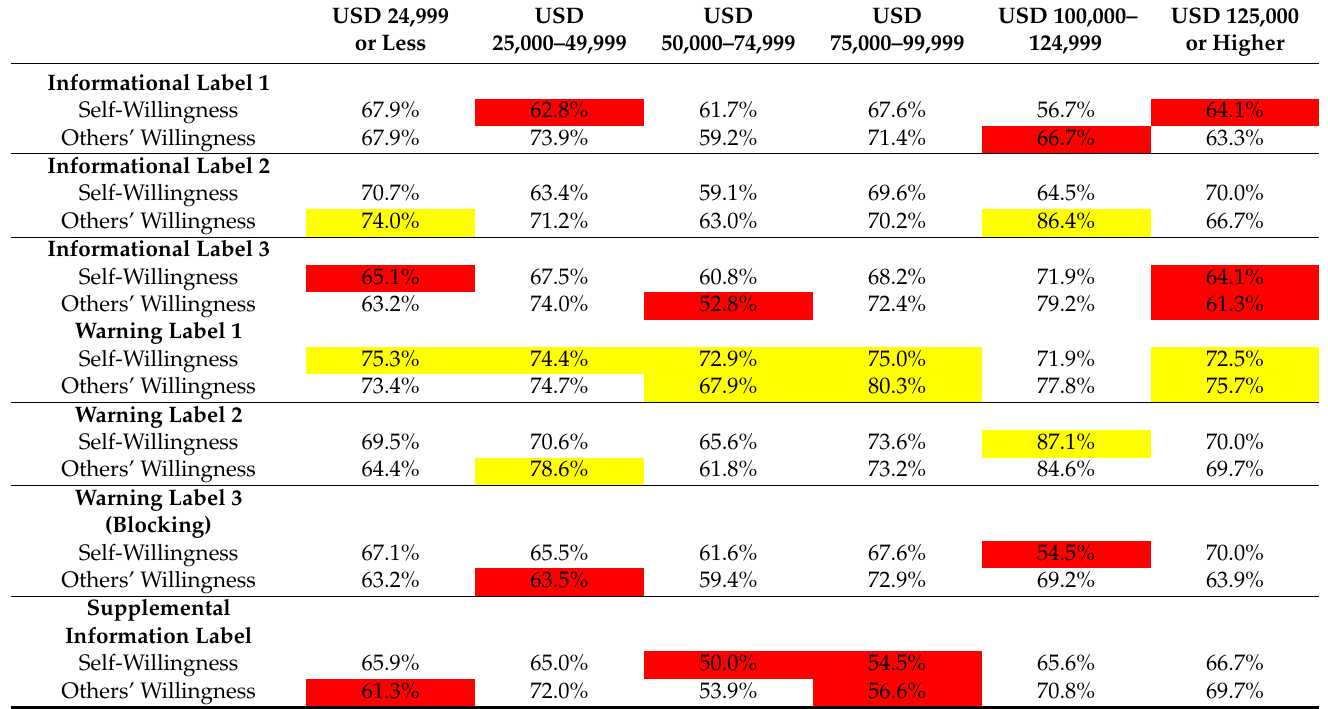
Table 4. Comparison of self and others’ willingness to use labels by income